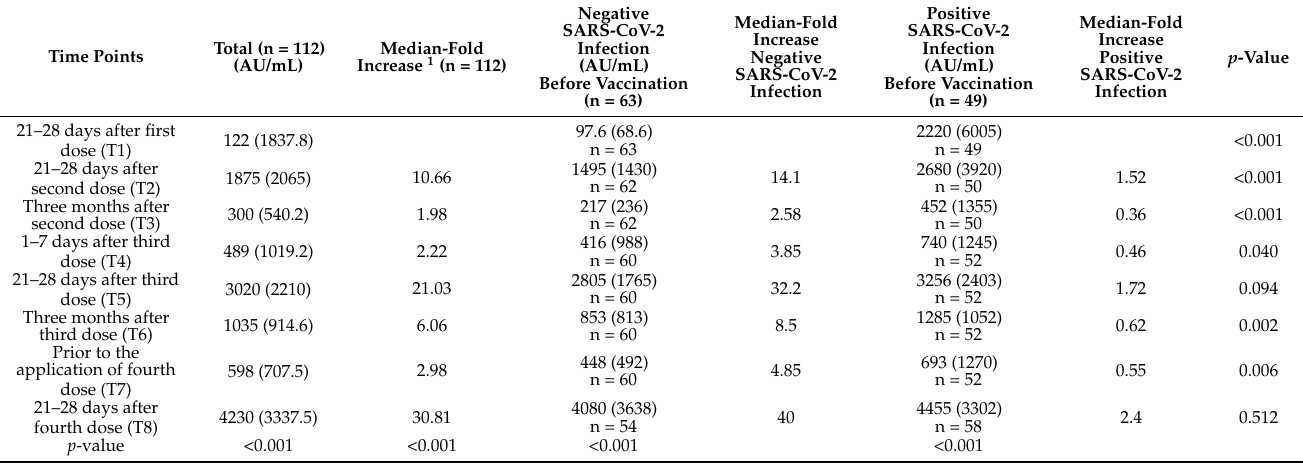
Table 1. Follow up of anti-S1-S2 IgG antibody titers according to SARS-CoV-2 infection history.